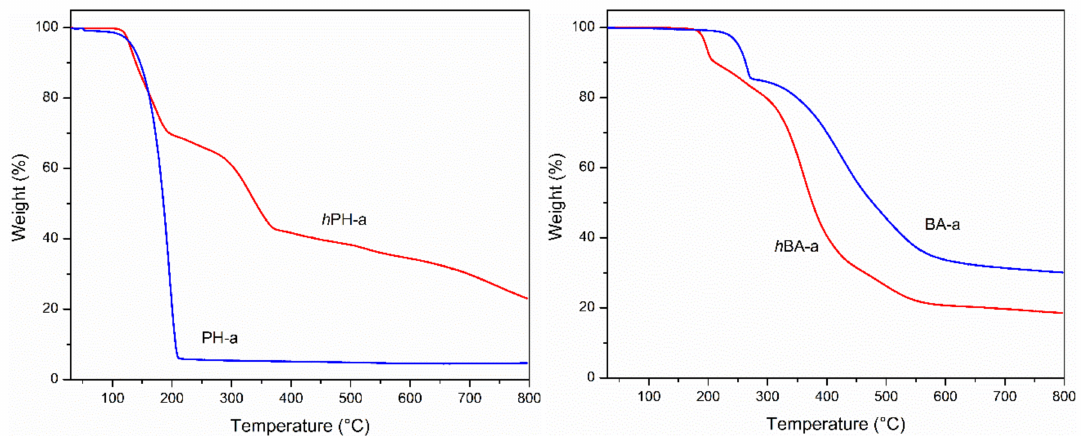
Figure 4. TGA curves of h PH-a and PH-a, h BA-a and